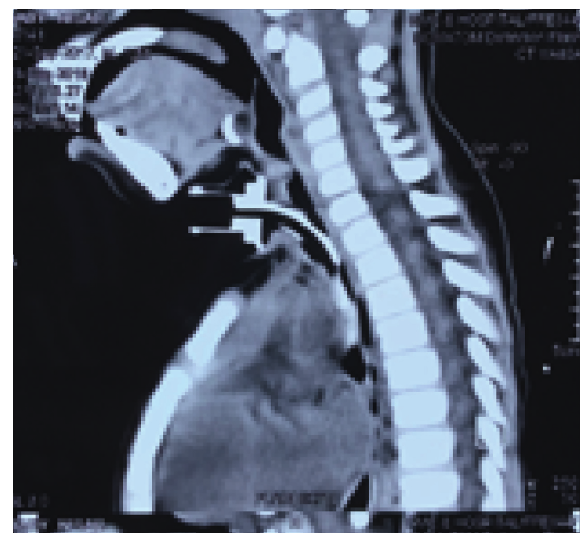
Figure 9: Postoperative CT image showing adequate subglottic airway lumen.